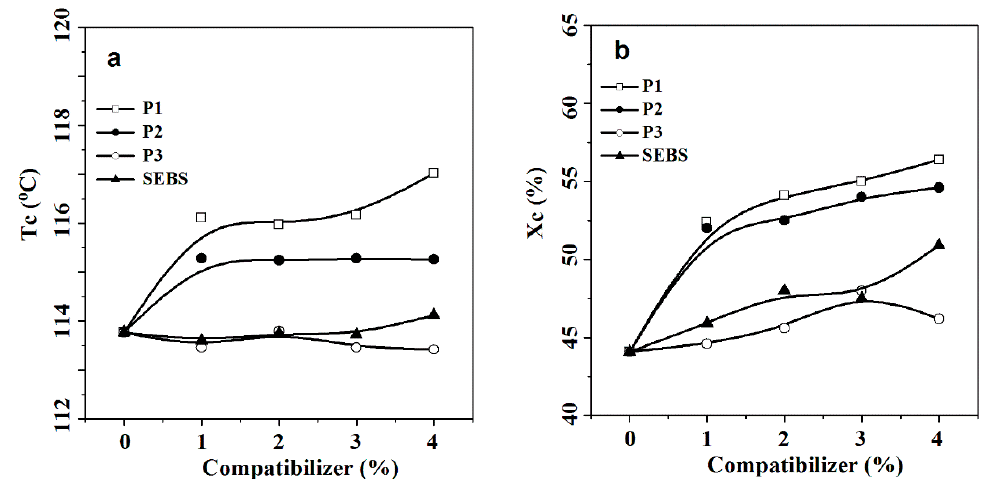
Figure 7. Variation of crystallization temperature ( T c ) ( a ) and crystallinity (X c ) ( b ) of blends with varied amounts of compatibilizer.